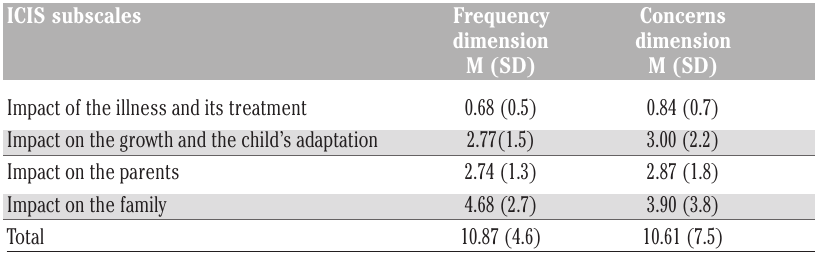
Table 1. Descriptive analysis about ICIS scores reported by parents with coeliac disease children